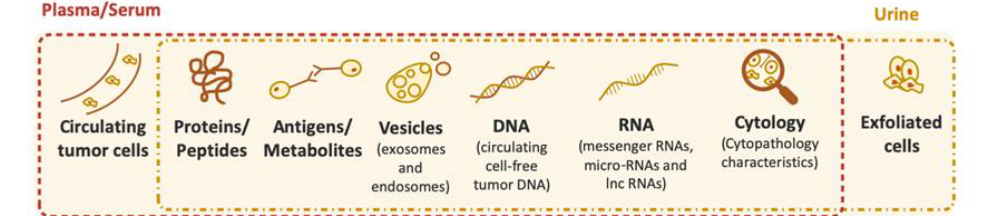
Figure 2. Non-invasive targets and starting